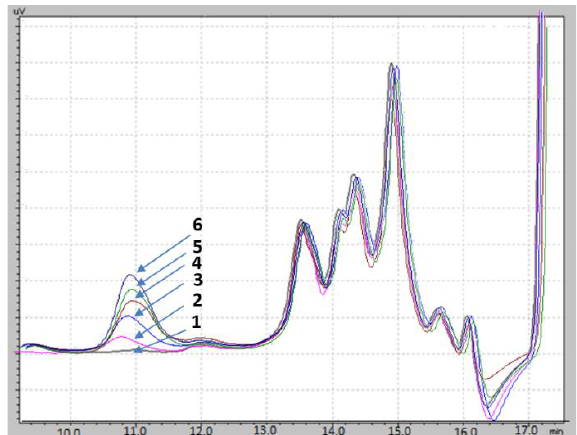
Figure 1. Chromatograms obtained from adulterated milk samples with cheese whey: (1) 0% unadulterated milk sample, (2) 2.5% adulterated sample, (3) 5% adulterated sample, (4) 7.5% adulterated sample, (5) 10% adulterated sample, and (6) 12.5% adulterated sample. A distinct single signal appeared at 10.8 min retention time. An increase in the chromatographic area was noticeable as the percentage of cheese whey increased in the adulterated milk.